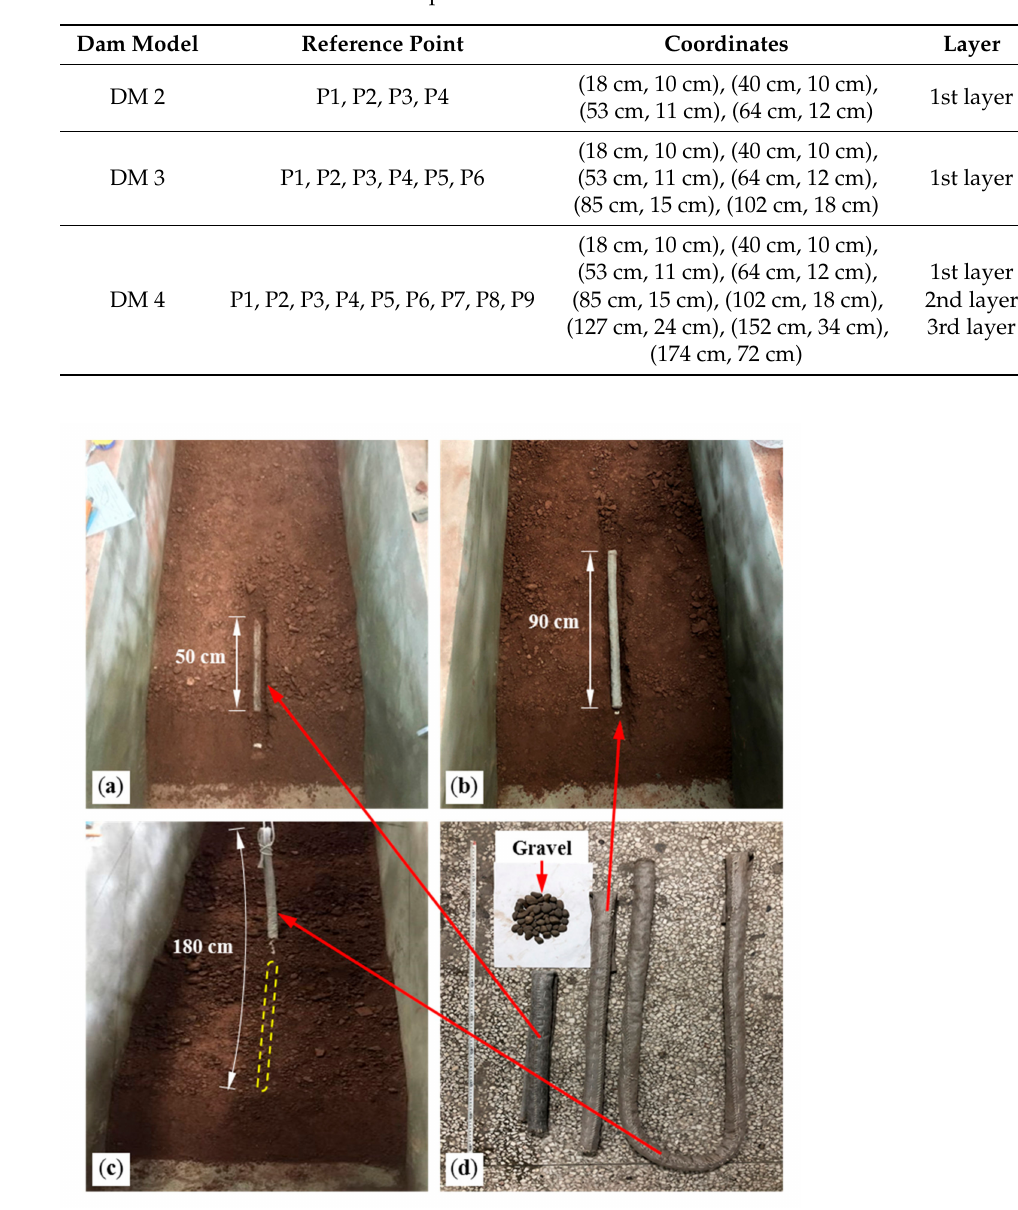
Figure 3. Geotextile tube arrangements in different dam models. ( a ) DM 2; ( b ) DM 3; ( c ) DM 4; ( d ) The three tubes used and the gravel encased in the